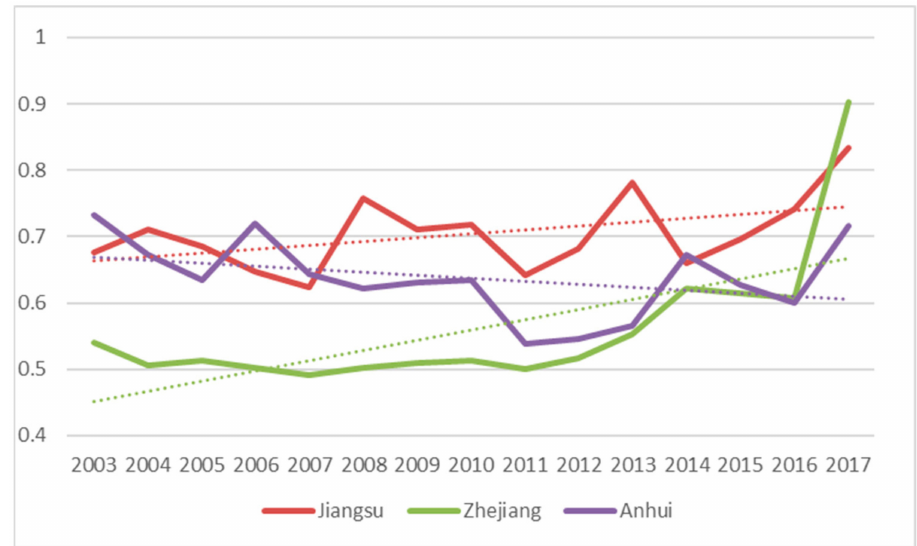
Figure 4. Average Value of Urban Land Use- Efficiency in Each